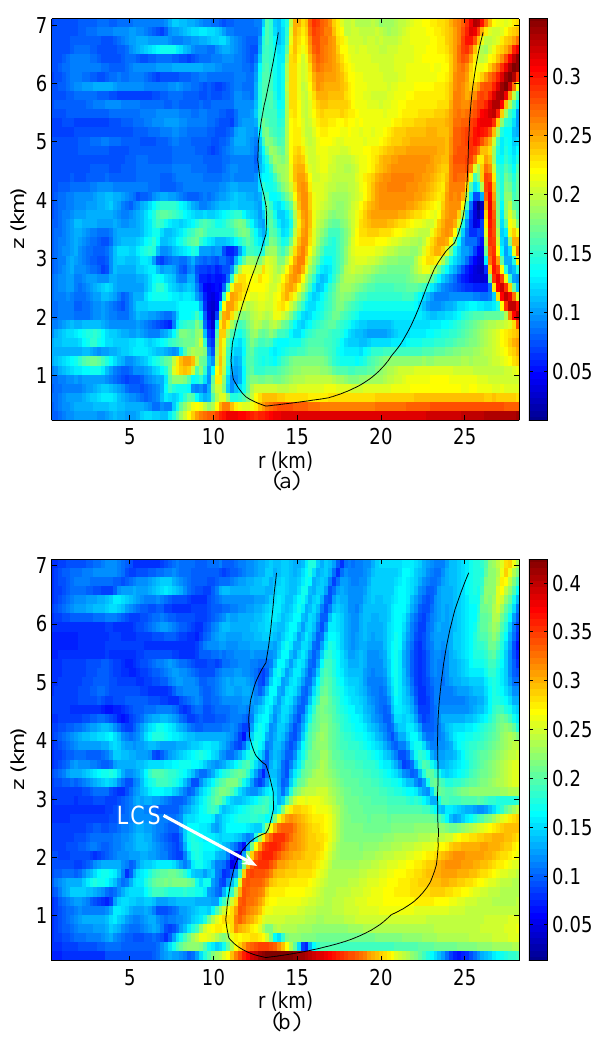
Fig. 8. Forward (a) and backward (b) time FTLE fields at t 0 = 400 minutes with 1 m/s vertical wind contour. The persistent LCS is marked in (b).